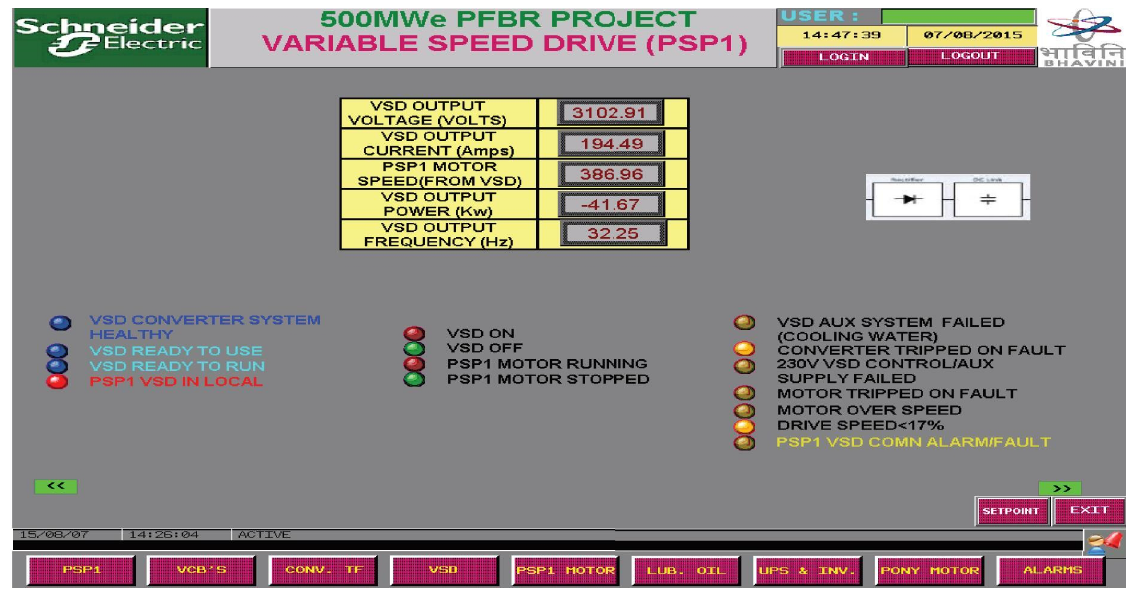
Figure 22: Drive output in